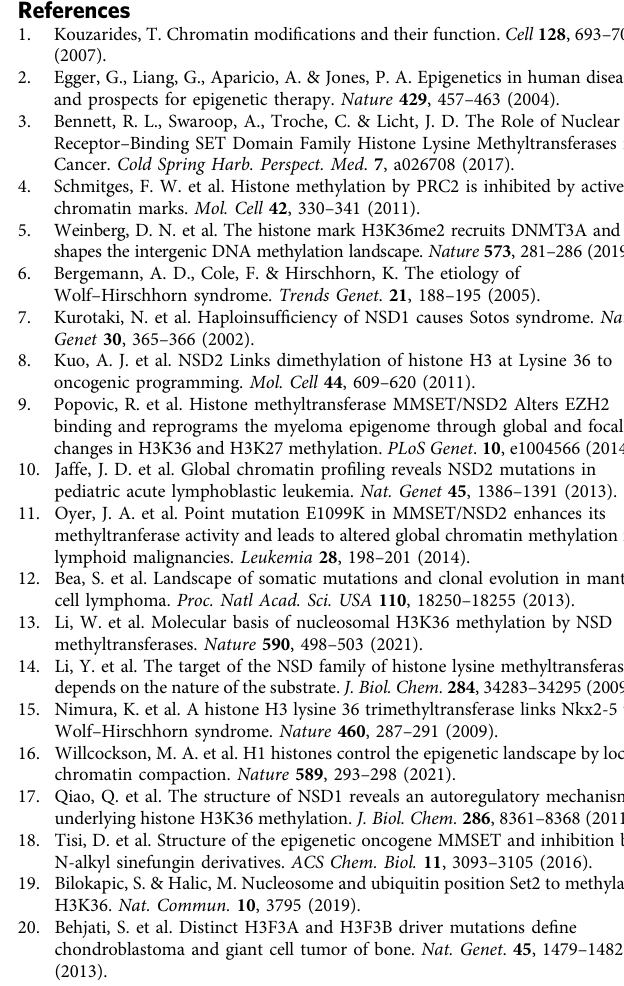
Figure preparation . Structural fi gures were created using PyMOL (Schrödinger, LLC) and UCSF ChimeraX 59 . Sequence alignment fi gures were created using ESPript 60 . Both trajectory visualization and movie creation were accomplished using VMD 61,62